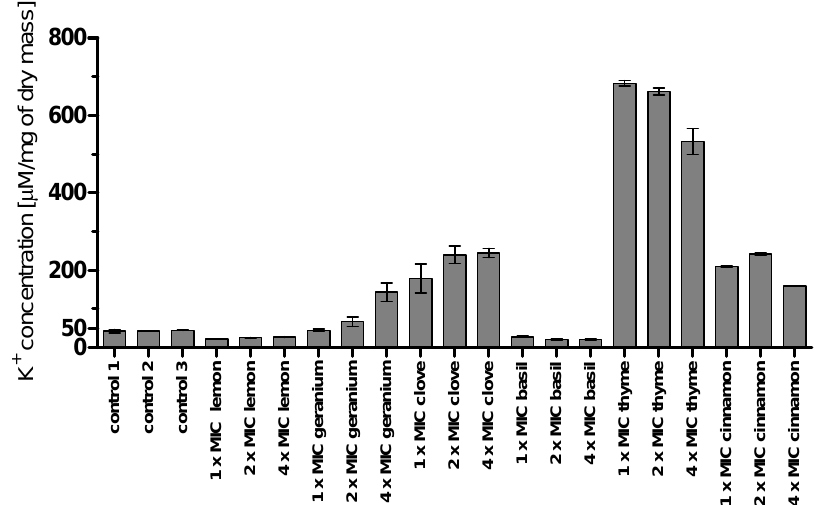
Figure 3. Potassium ion efflux induced by EOs at three concentrations 1 × MIC, 2 × MIC, and 4 × MIC. Error bars indicate uncertainty of measurement.